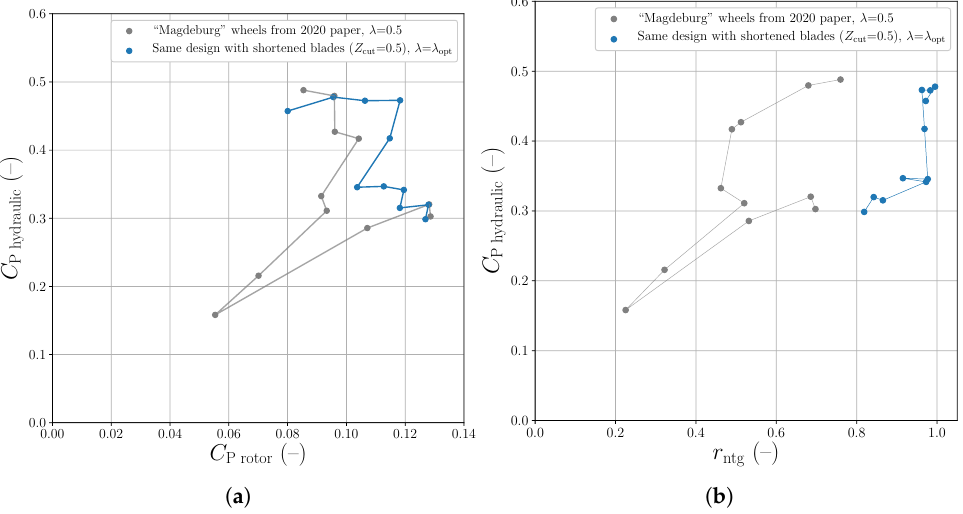
Figure 14. Performance of wheels of the “Magdeburg” family of designs, constructed in previously published work [17], compared to the same wheels modified with their blades shortened at Z cut = 0.5. In those two series of simulations, the wheels range from 6m in diameter (wheels with the best C P , hydraulic ) down to 0.4m in diameter (wheels with best C P , rotor ). Part ( a ) displays the wheels’ power output performance (hydraulic vs. rotor power coefficient), while part ( b ) displays the wheels’ hydraulic power coefficient vs. work ratio r ntg